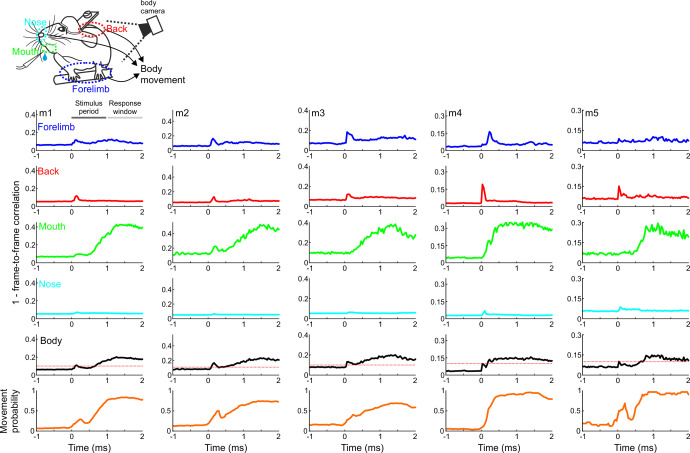
Movement of different body parts with respect to stimulus onset.Movement of different body parts (Forelimb, Back, Mouth, Nose; Body movement was the average of forelimb, back and mouth; quantified as one minus the frame-to-frame correlation of those areas) along with the movement probability (bottom) for five expert mice. Dashed red line in the body movement panel indicates the movement threshold.